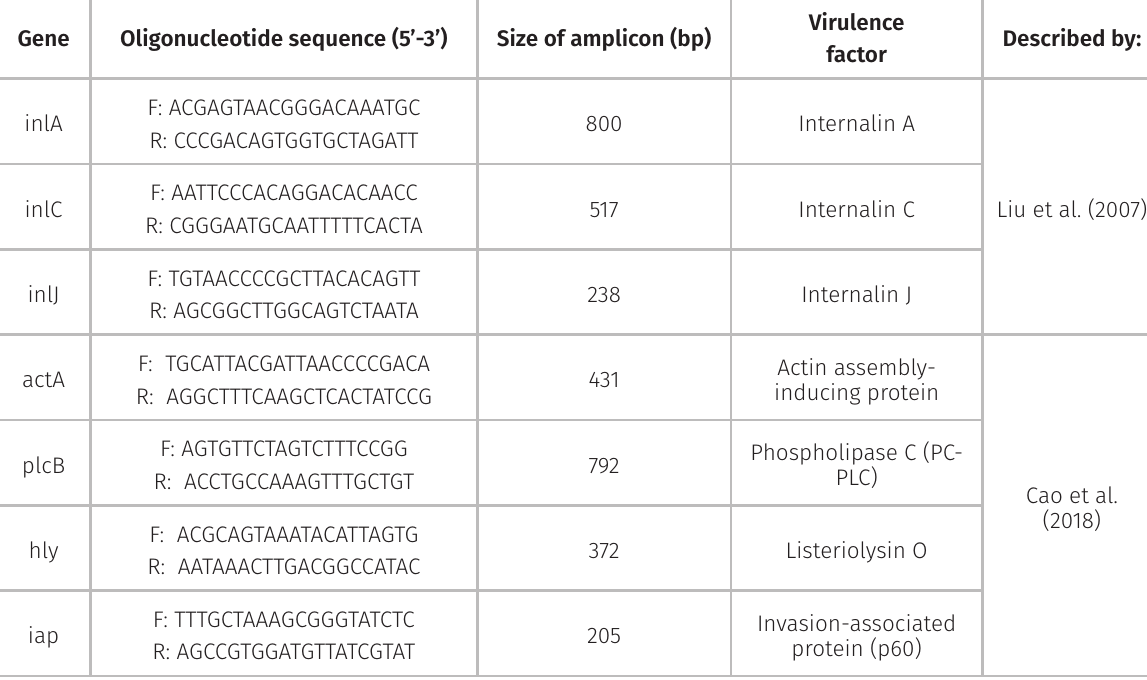
Table I. List of primers used to detect virulence genes in Listeria monocytogenes isolates . Gene Oligonucleotide sequence (5’-3’) Size of amplicon (bp)